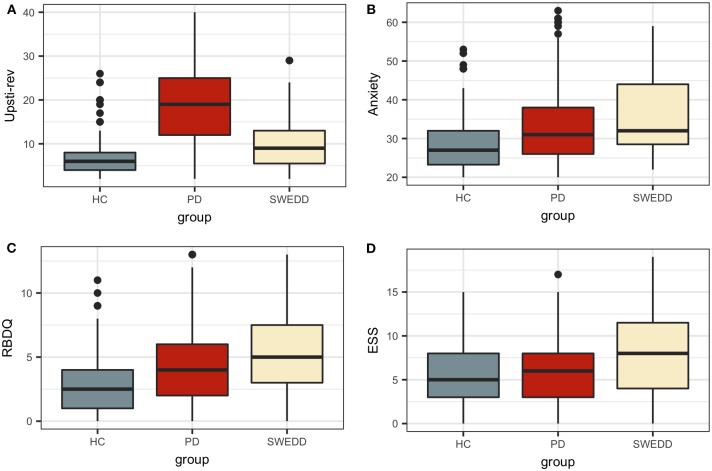
Clinical predictor boxplots. (A) Upsit-rev, University of Pennsylvania Smell Inventory Test score reverse-scaled; (B) anxiety, trait subscale from the State-Trait Anxiety Inventory; (C) RBDQ, rapid eye movement behavior disorder questionnaire; (D) ESS, Epworth Sleepiness Scale; HC, healthy controls; PD, early PD; SWEDD, scans without evidence of dopamine deficit.